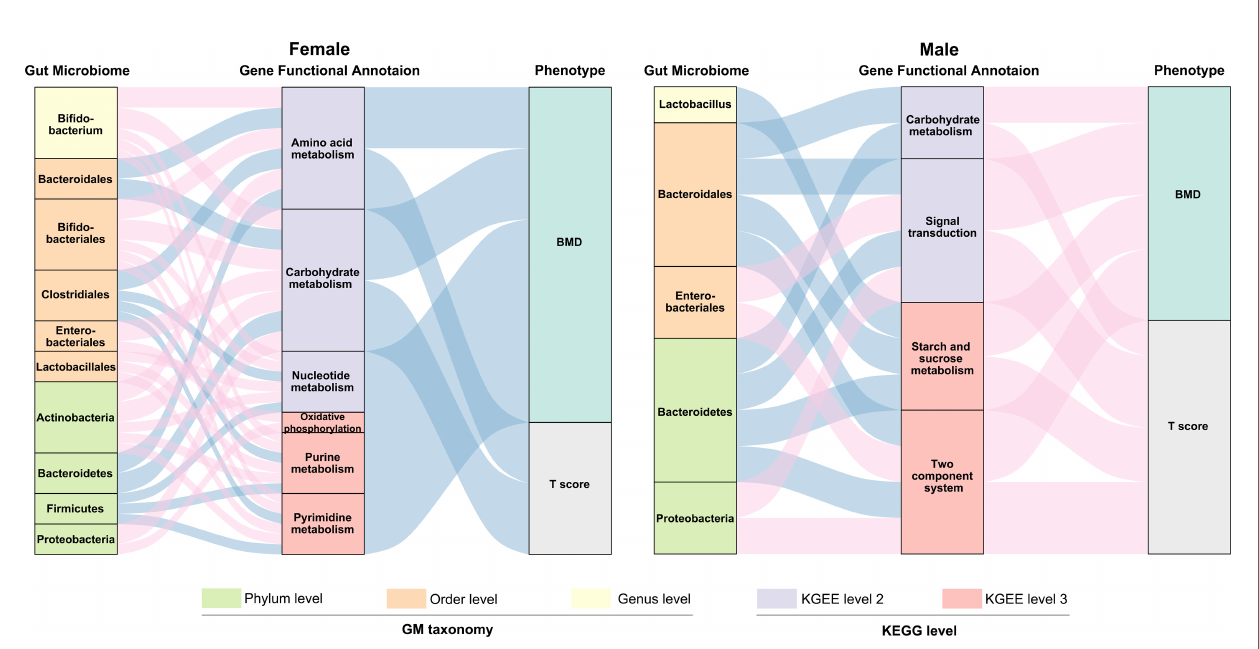
FIGURE 6 | Interrelationship between GM composition, gene functional signature and BMD-value/T-score. Visualization of the correlation network according to Pearson correlation tests ( P < 0.05 for all the correlations), red connection indicates a positive correlation, while blue connection represents a negative correlation. The detailed coef fi cient values were showed in Table S5